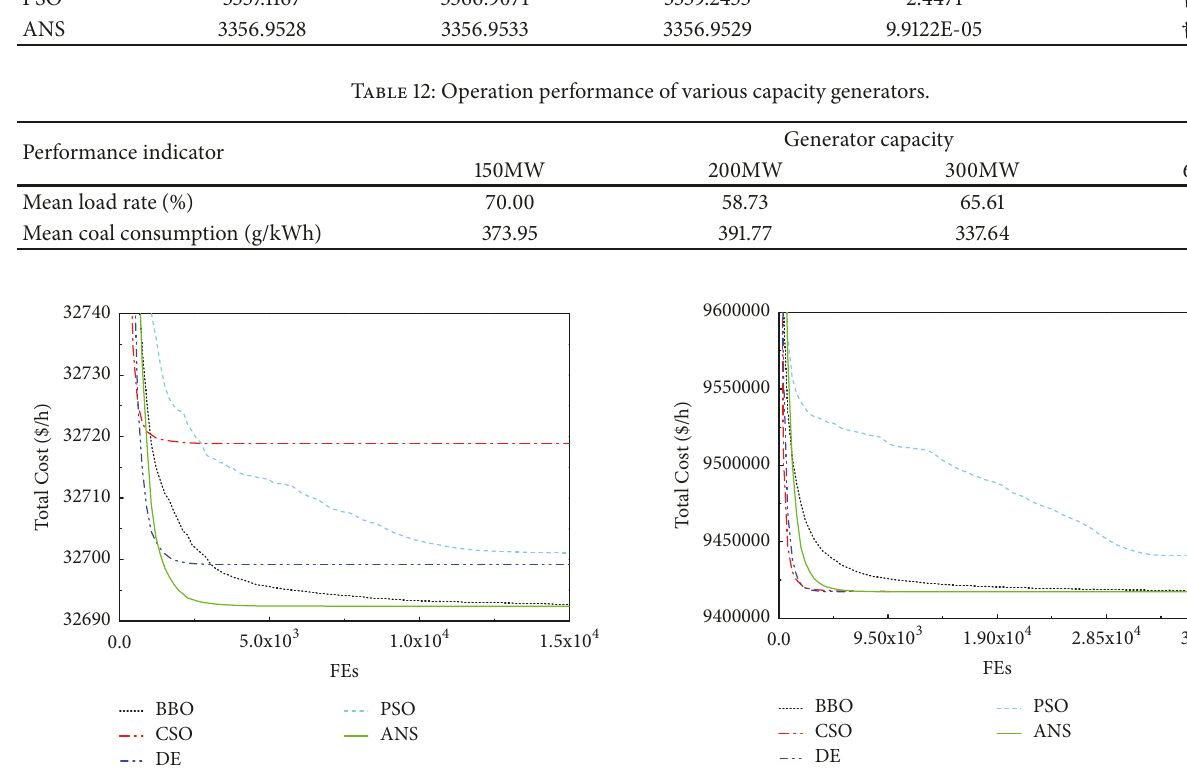
Figure 3: Convergence curves for the 15-generatorsystem (CaseII). Figure 4: Convergence curves for the 38-generator system (Case